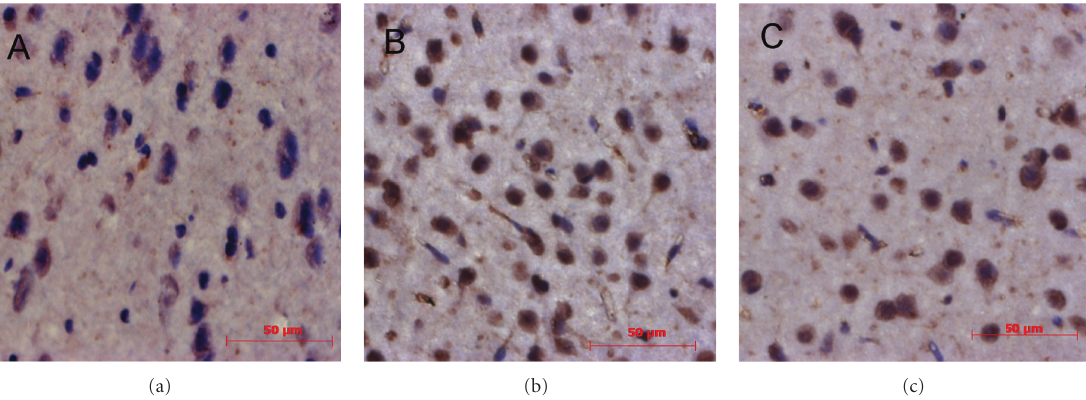
Figure 4: Representative photographs of the NF- κ B p65 expression in brain cortex. The subunit of NF- κ B p65 was detected by immunohistochemistry in the control (a), day 3 (b), and day 10 groups (c). In the control group, p65 concentrated around the nuclei; while in day 3 and day 10 groups, most of the cellular nuclei were filled with p65. (Scale bar, 50 μ